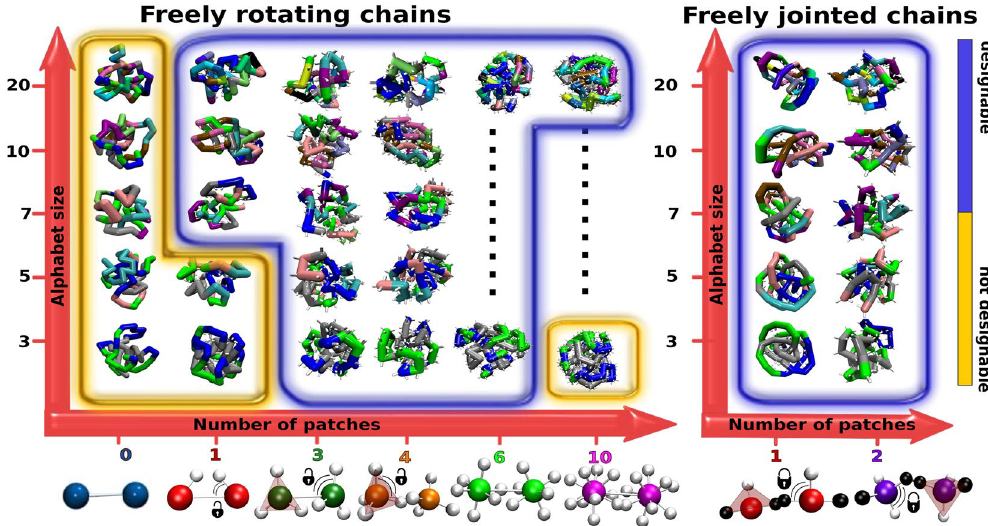
Figure 3. Designability diagram for different patch numbers and alphabet sizes. Within the yellow regions, the heteropolymer is not designable, while the blue regions correspond to designable systems. For each case, the chosen target structure is shown. Bottom panel: a schematic illustration of patchy polymers. White spheres indicate the patches located at the surface of the central monomer. For FRC (left) we consider from 0 (simple heteropolymer case) to 10 patches and 1 and 2 patches for FJC (right). With the exception of the one patch geometry, in all the other cases the patches are fixed on the vertices of a platonic solid or in the most symmetric way (Supp. Mat.). The two patch FJC are placed on a tetrahedron completed by the anchoring points (in black). For both models, we consider alphabet sizes q ranging form q = 3 to q = 20 (see Methods 1 for the definition of the